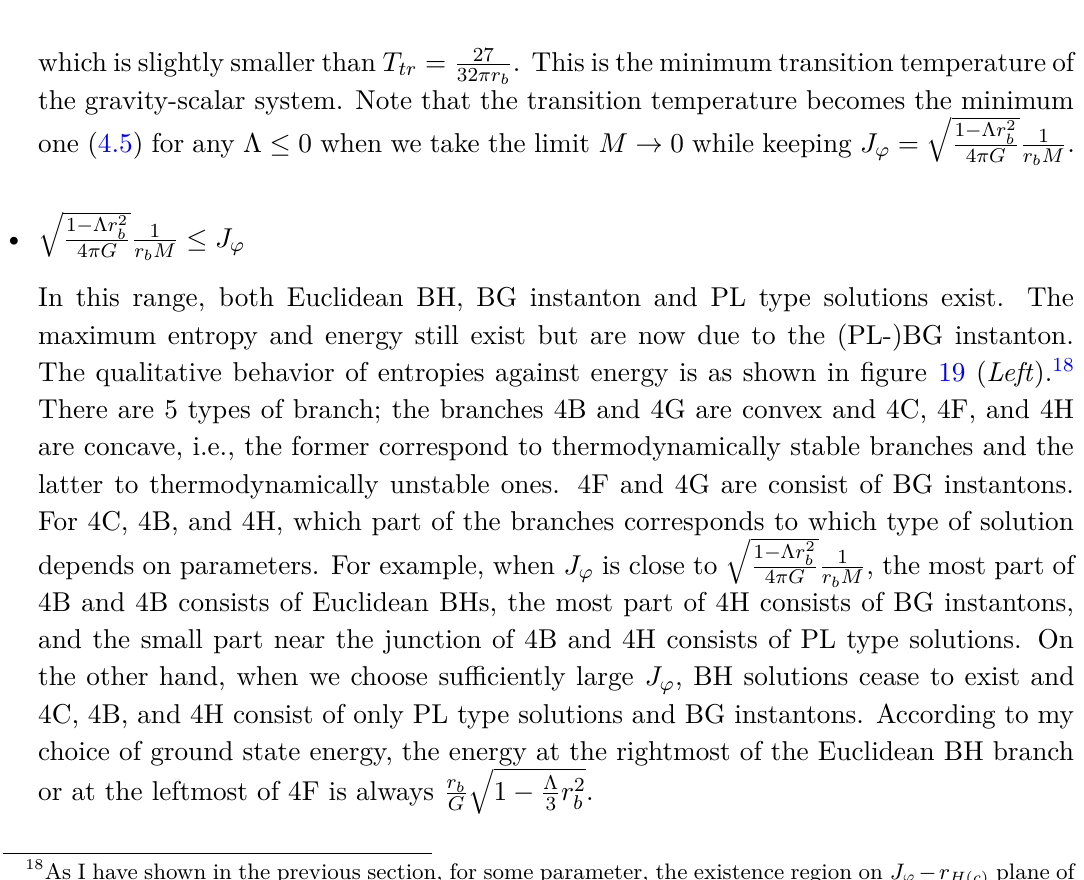
Figure 18 . Relation between transition temperature T tr and M with fixing J ϕ = √ when Λ = 0 , r = 5 G . As we decrease M , T tr also decreases and T tr reaches the minimal value b q in the limit M → 0 . For J 2 1 3 πr b